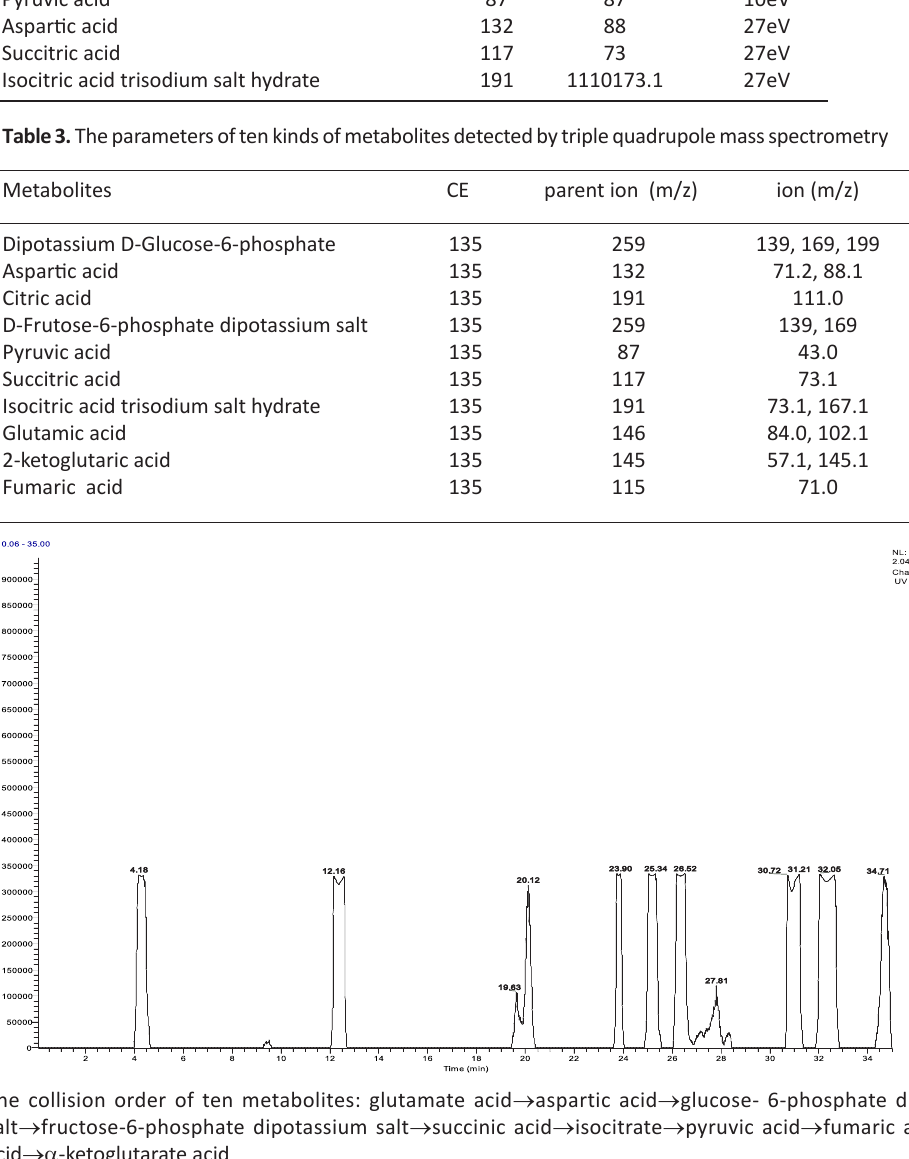
acid →α -ketoglutarate acid Fig. 1. Mixing spectrum of ten different